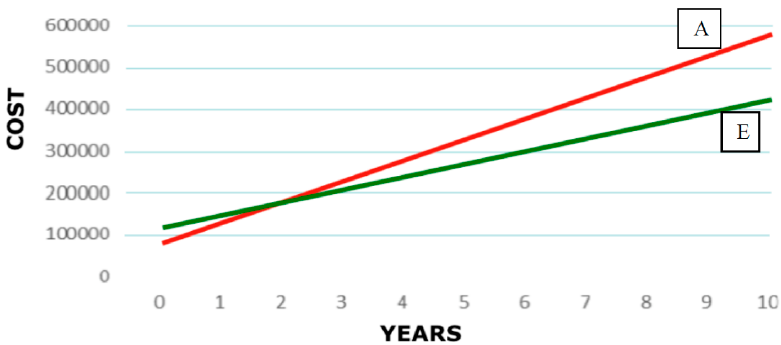
Figure 22. Comparison in terms of return on investments between a transcritical R744 booster refrigeration plant outfitted with multi-ejector block (green line) and a conventional transcritical R744 booster refrigerating unit (red line) in a supermarket located in Bari [47].